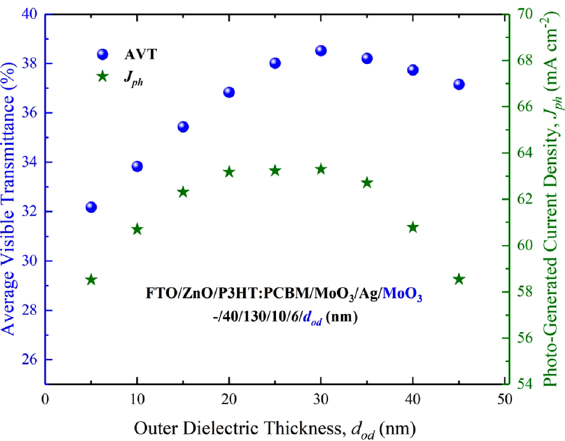
Figure 8. AVT and J ph changes of FTO/ZnO/P3HT:PCBM/MoO 3 /Ag/MoO 3 . (–/40/130/10/6/ d od nm) ST-OSC according to d od